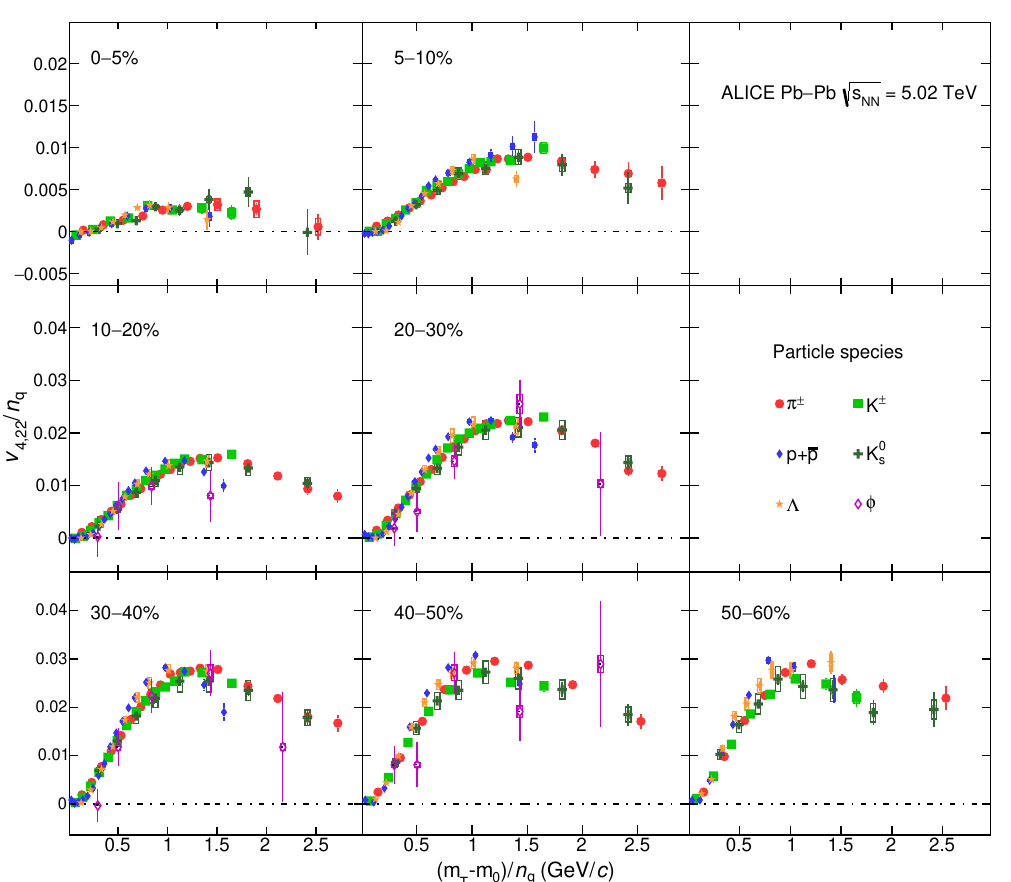
Figure 22 . The ( m T (cid:0) m 0 ) =n q -dependence of v 4 ; 22 =n q for di(cid:11)erent particle species grouped into p di(cid:11)erent centrality intervals of Pb-Pb collisions s NN = 5 : 02 TeV. Statistical and systematic un- certainties are shown as bars and boxes, respectively. It is seen that the KE T scaling holds for v 4 ; 22 at an approximate level.